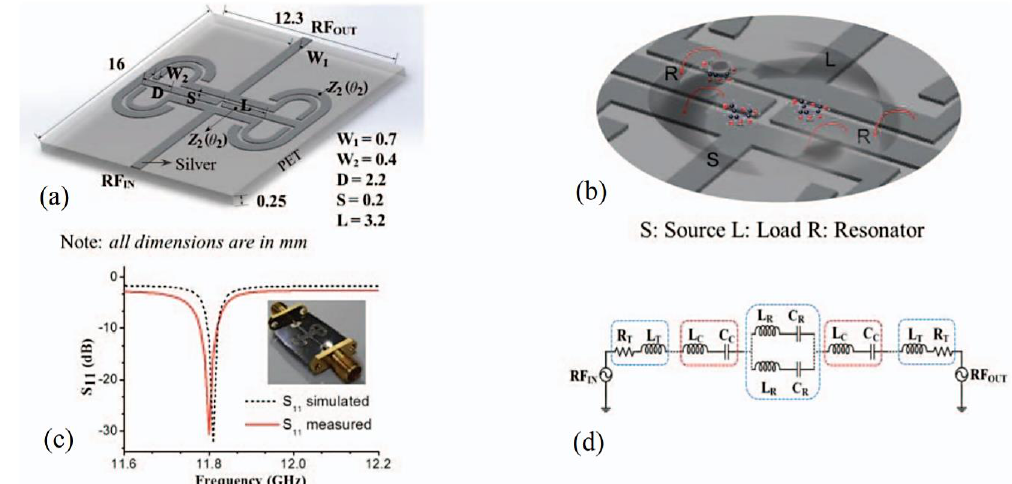
Figure 25. Proposed flexible glucose biosensor: ( a ) 3D layout of the resonator fabricated on a PET substrate; ( b ) schematic view of the sensing region of the resonator with a glucose–water solution; ( c ) simulated and measured S 11 , including a photograph of the fabricated resonator; and ( d ) the equivalent circuit of the proposed biosensing resonator [94].